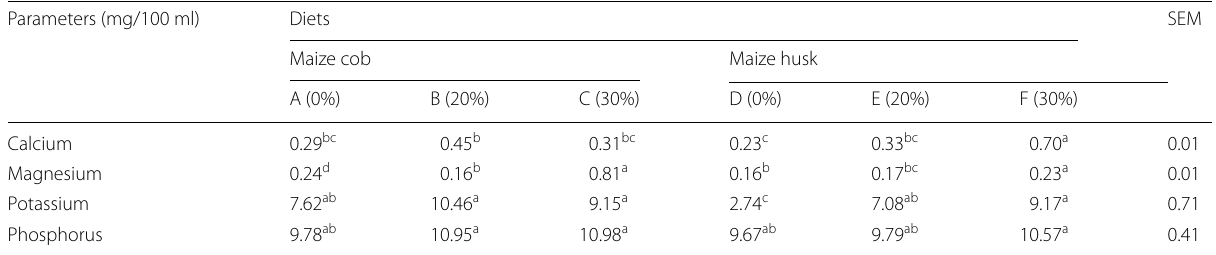
Table 4 Serum electrolytes of WAD goats fed treated maize cob- and husk-based diets with mixture of microorganisms